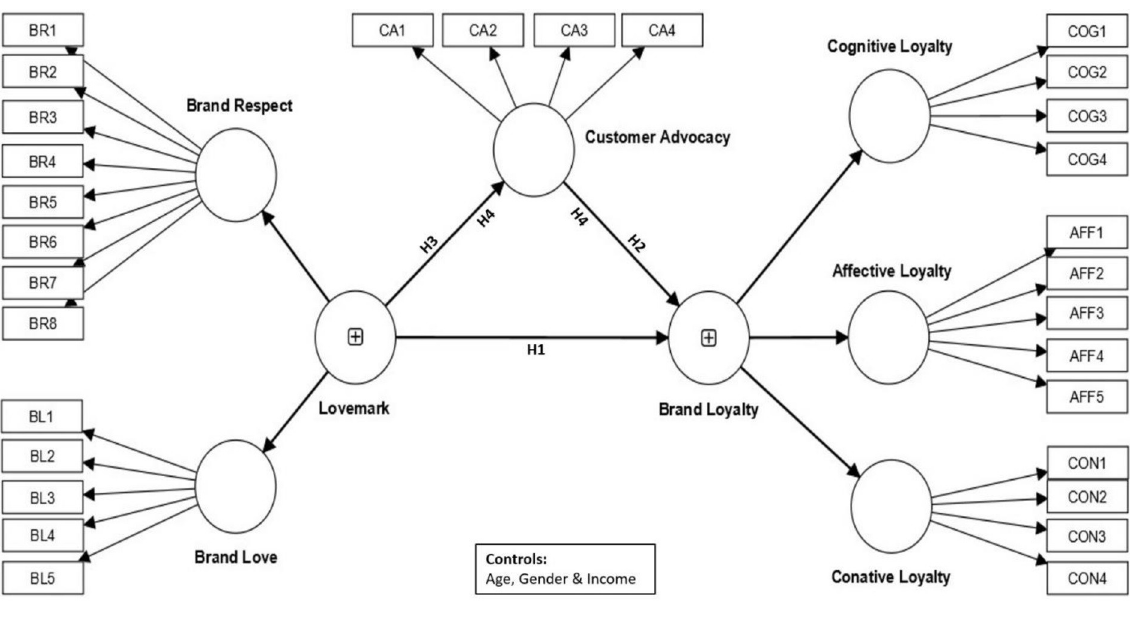
Fig 1. Conceptual